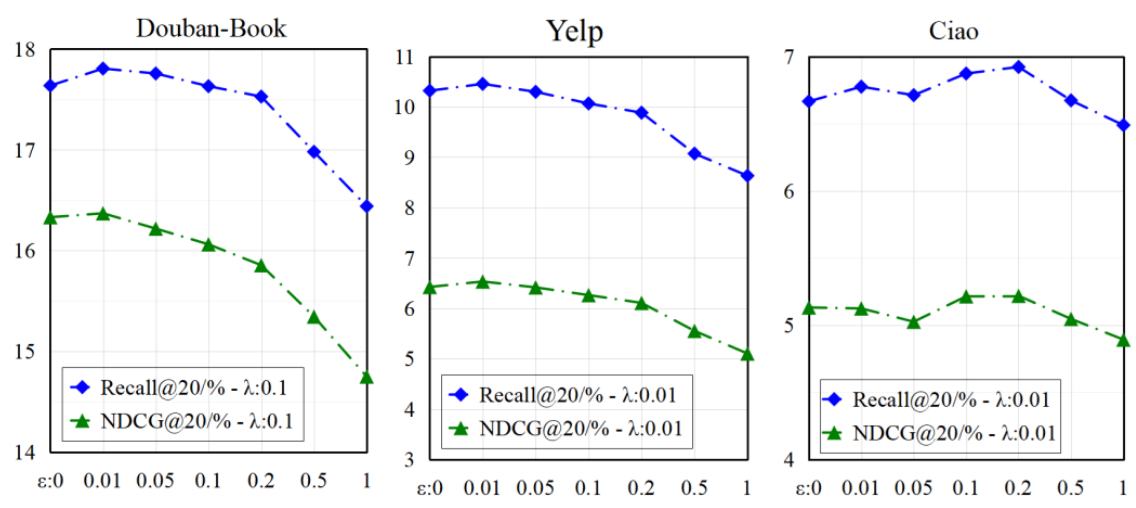
Figure 8. The influence of ε .